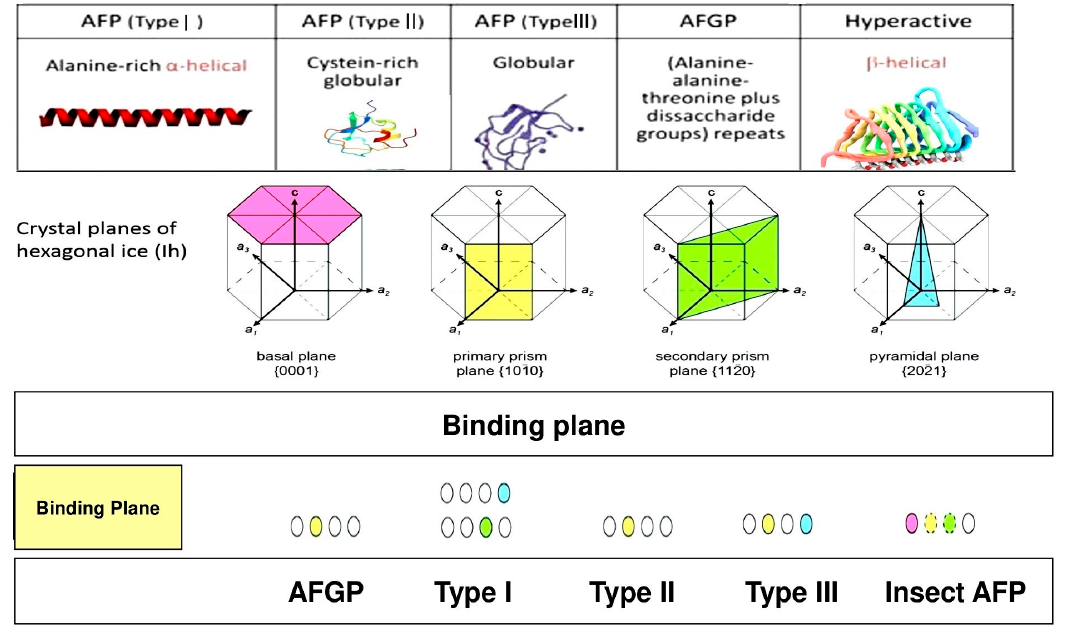
Figure 3. Structural properties of AFPs based on binding to ice crystal planes, which are widely different due to the types and structure of AFPs. Type I AFP has a primary prism shape of the ice plane. Other types can form basal plane, secondary prism, and pyramidal shapes once they interact with ice/water [14].